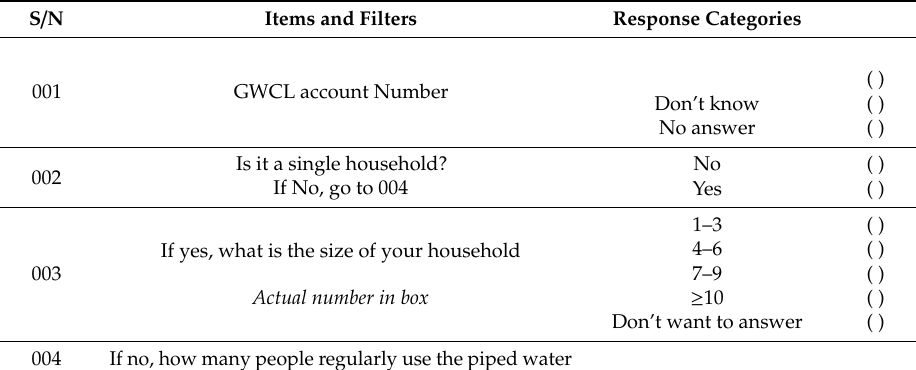
√ ) the appropriate box.